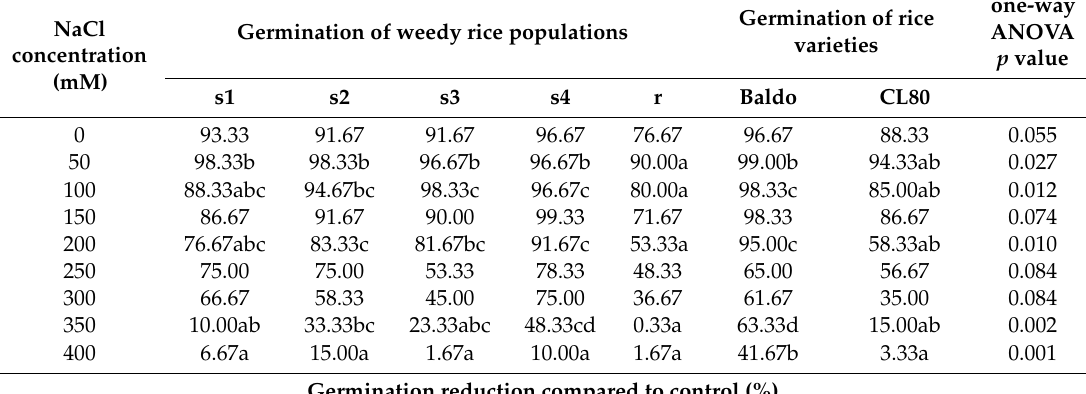
Table 1. Seed germination percentage (after 15 days) and germination reduction at each NaCl concentration compared to control of weedy rice and rice varieties. Comparisons were made among rice varieties and weedy rice populations, separately for each NaCl concentration (among values on the same row). Values sharing the same letters are not significantly di ff erent according to Waller-Duncan test ( α ≤